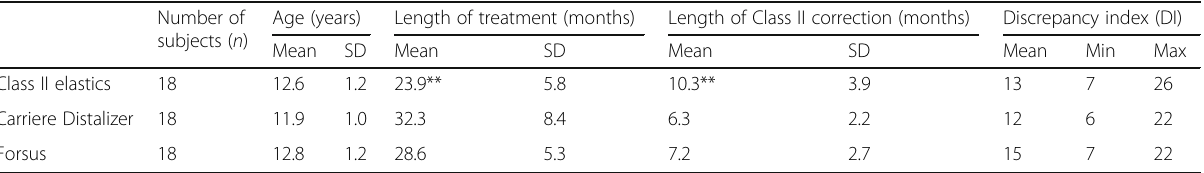
Table 1 Baseline information of subjects in each group. ** P < 0.01